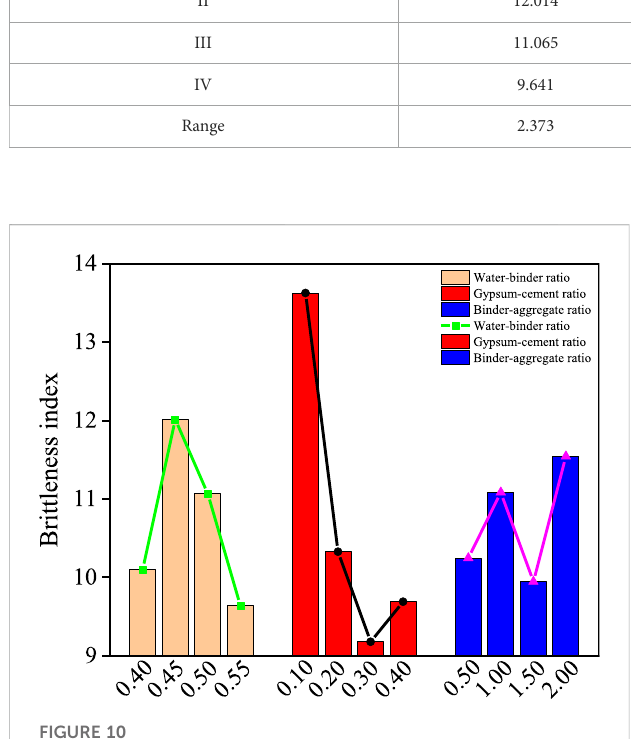
FIGURE 10 The gypsum-cement ratio has the greatest effect on the brittleness index with an extreme difference of 4.444, indicating that the ratio of gypsum to cement in the cementing agent has the highest degree of in fl uence on the material deformation